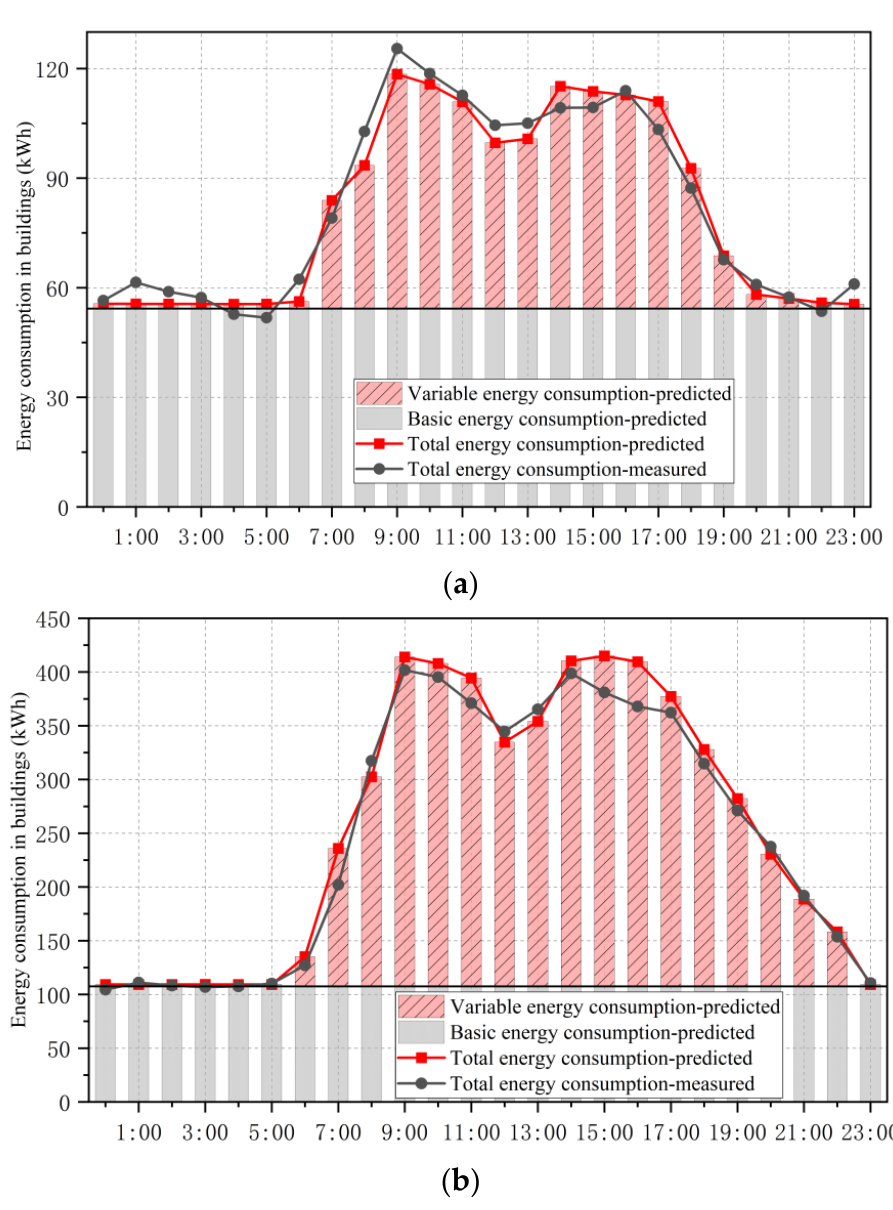
Figure 24. ( a ) Comparison of measured and predicted total energy consumption in Case Building A, ( b ) comparison of measured and predicted total energy consumption in Case Building B.